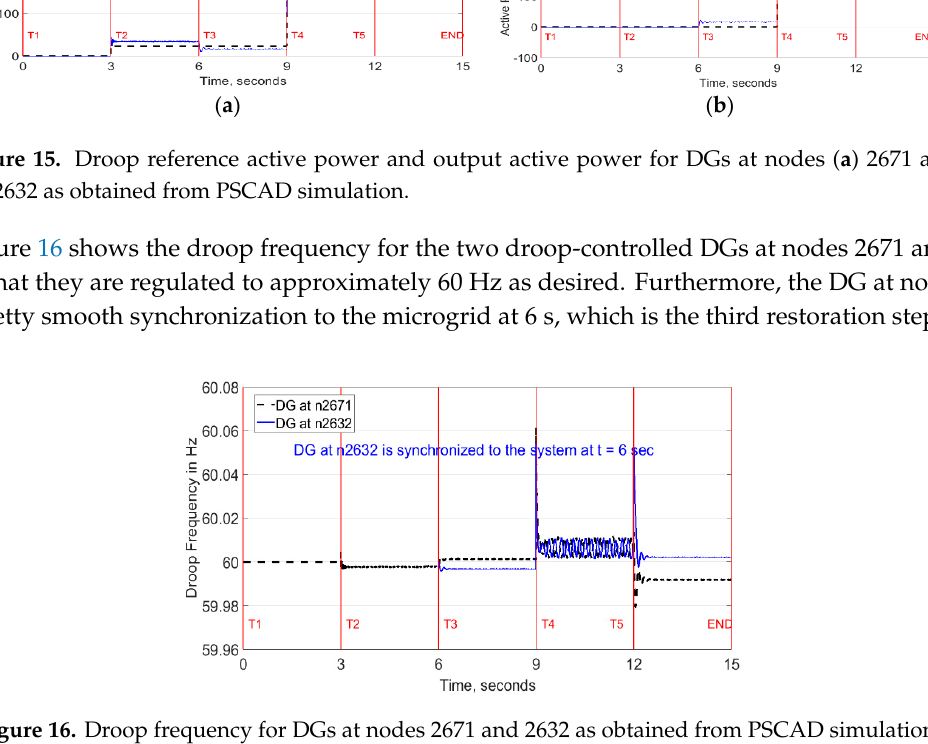
Figure 15. Droop reference active power and output active power for DGs at nodes ( a ) 2671 and ( b ) 2632 as obtained from PSCAD simulation.